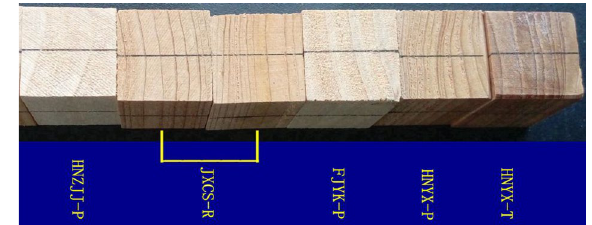
Figure 6. The cross-section photo of